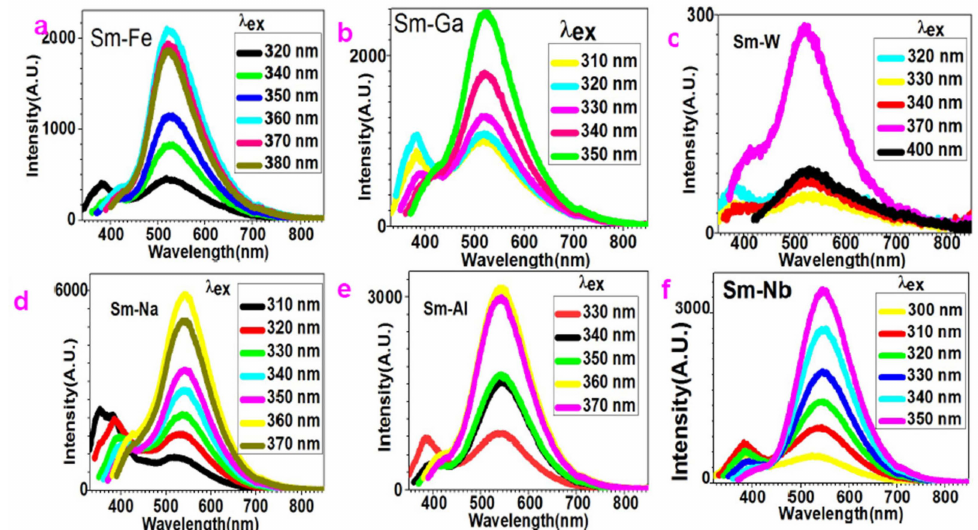
Figure 3. Sm–Fe, Sm–Ga, and Sm–W compound nanoparticles all show tunable white-to-green fluorescence by variation of excitation light around 300–400 nm: ( a ) Sm–Fe; ( b ) Sm–Ga; ( c ) Sm–W; ( d ) Sm–Na; ( e ) Sm–Al; ( f )